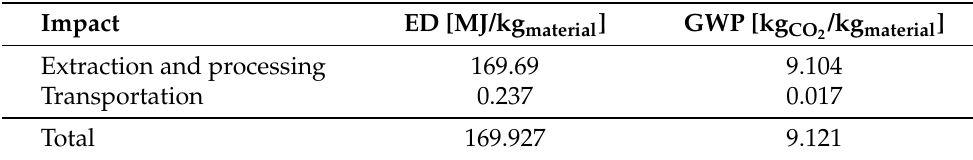
Table 11. Average ED and GWP related to the extraction, processing and transportation of the